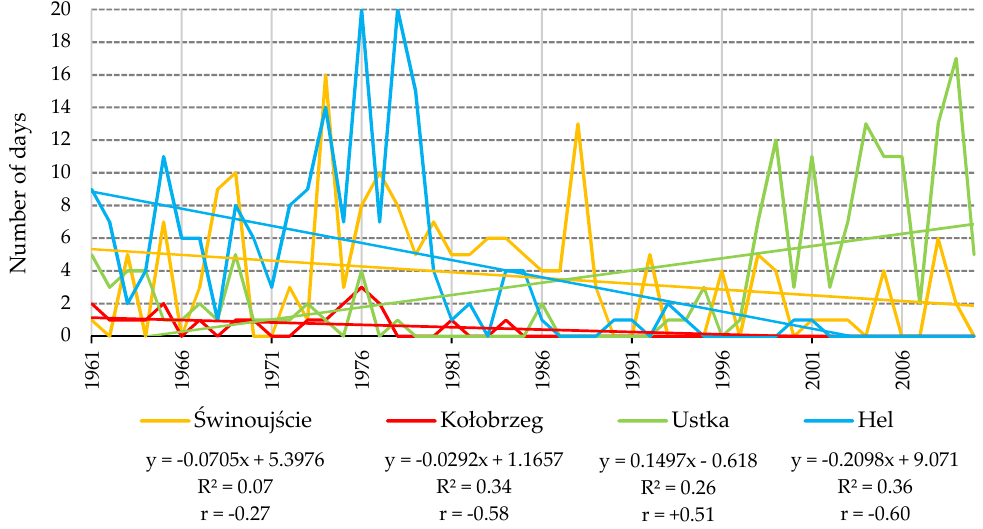
Figure 7. Annual trend of days with conditions particularly conducive to intensification of aeolian processes in the Polish Baltic coastal zone.